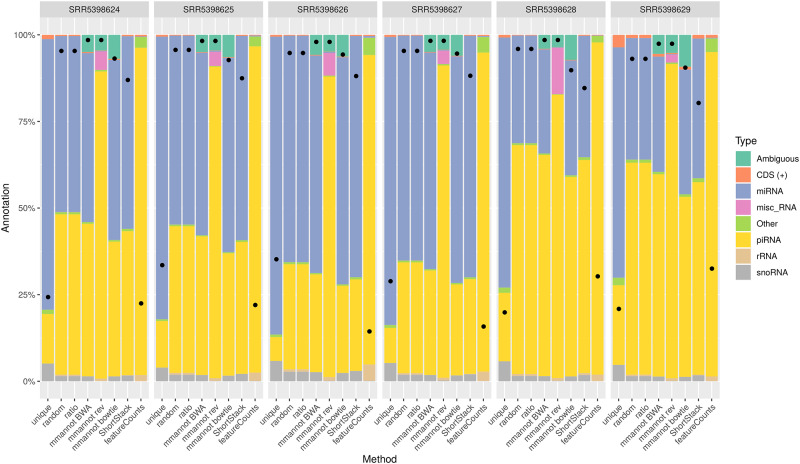
Comparison of the different strategies on the H. sapiens data sets.See Fig 2 for a legend of the plot.